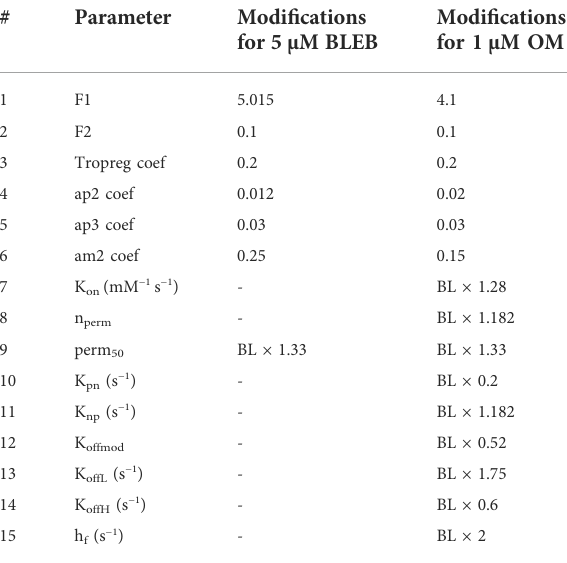
TABLE 4 The modi fi cations to the parameters to simulate the effects of BLEB and OM. BL: Baseline values of hiMCE model given in Table